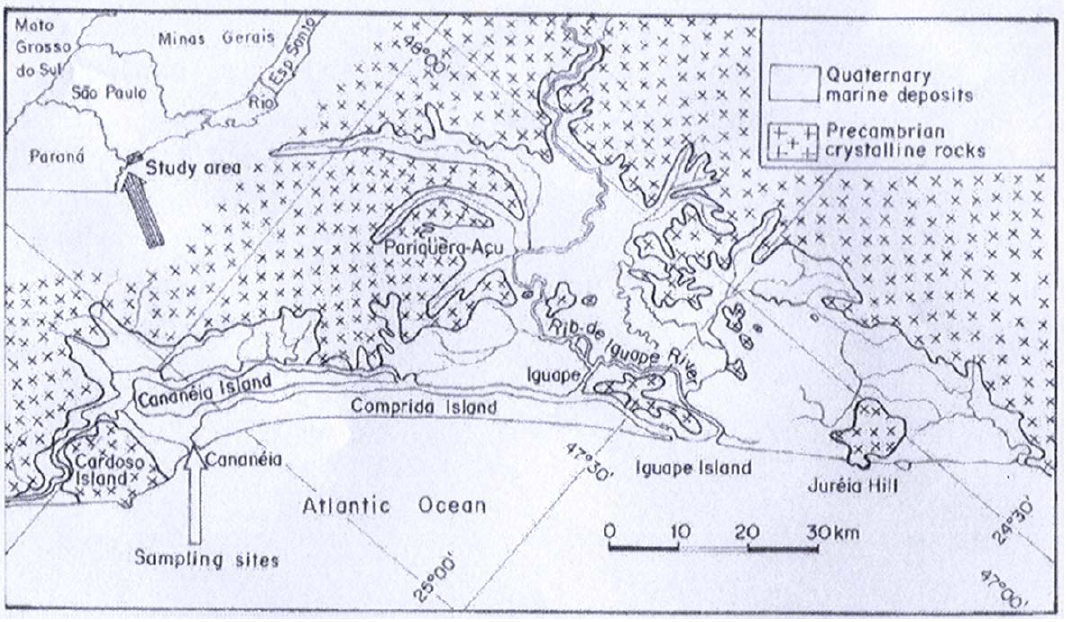
Fig. 1 – Quaternary Cananéia-Iguape coastal plain (southernmost São Paulo State), and the Comprida Island with indication of sampling